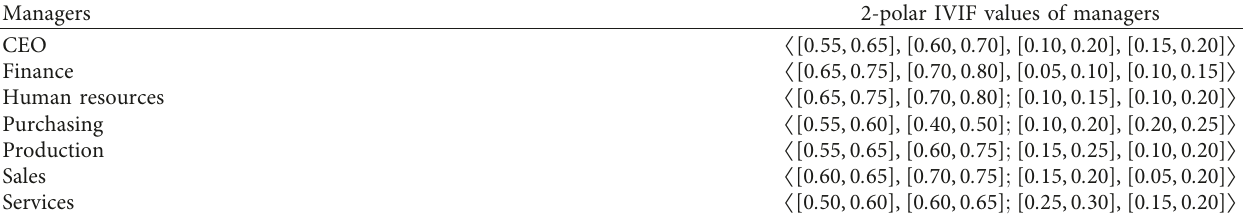
Table 4: 2-polar IVIF values of